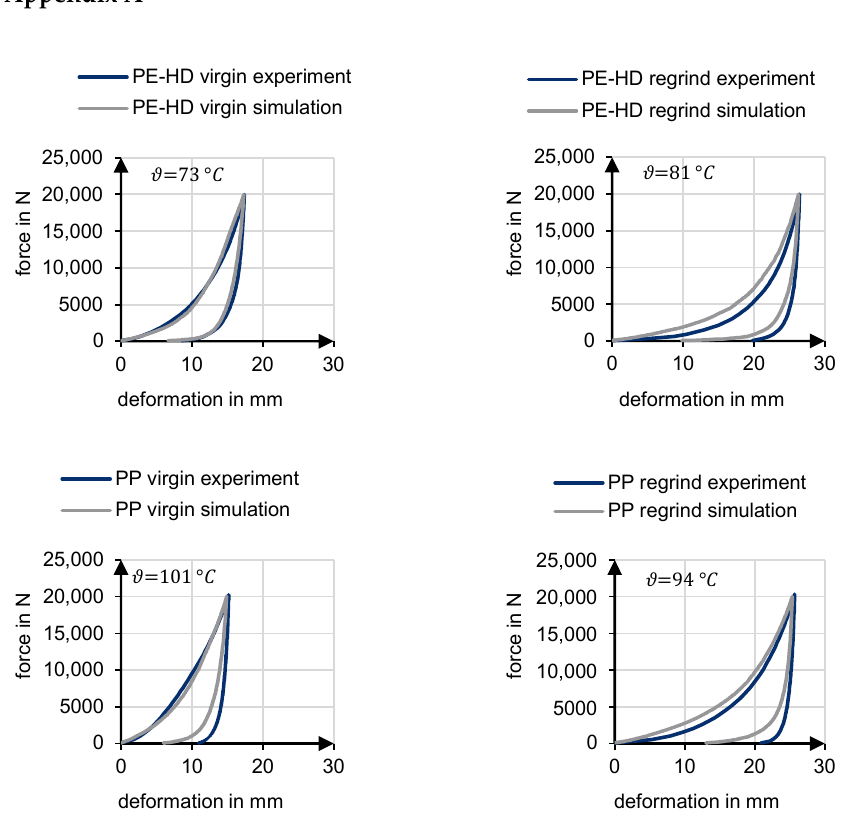
Figure A1. Comparison between experimental and simulation data of the compression test.